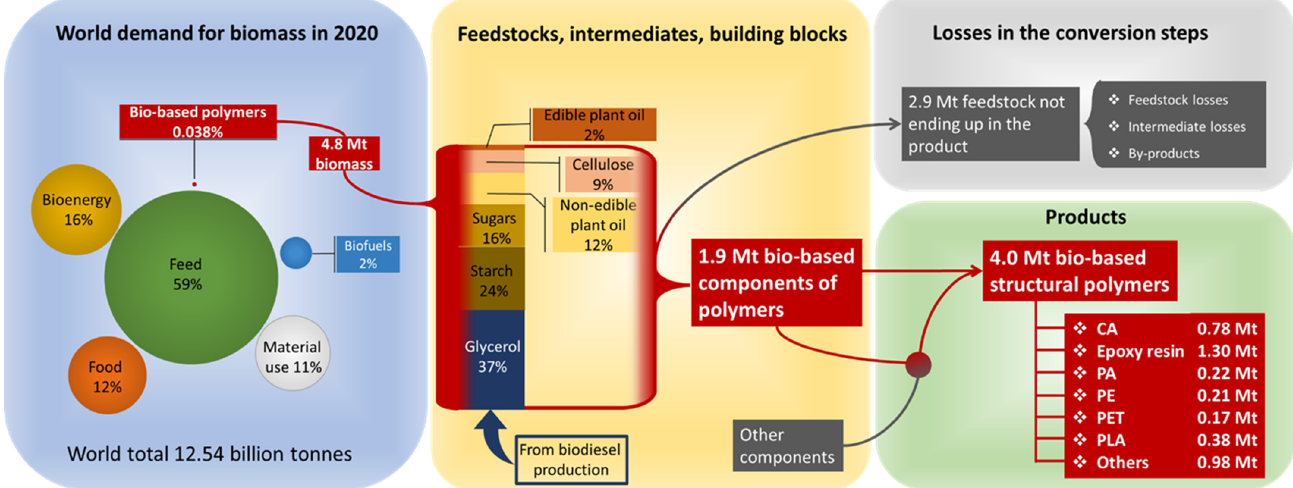
Figure 7. Diagram of the relationships between the biomass to produce bio-based polymers and bio-based structural polymers produced worldwide in 2020. Modified and adapted from Carus [47]. CA: cellulose acetate; PA: polyamide; PE: polyethylene; PET: polyethylene terephthalate; PLA: polylactic acid.